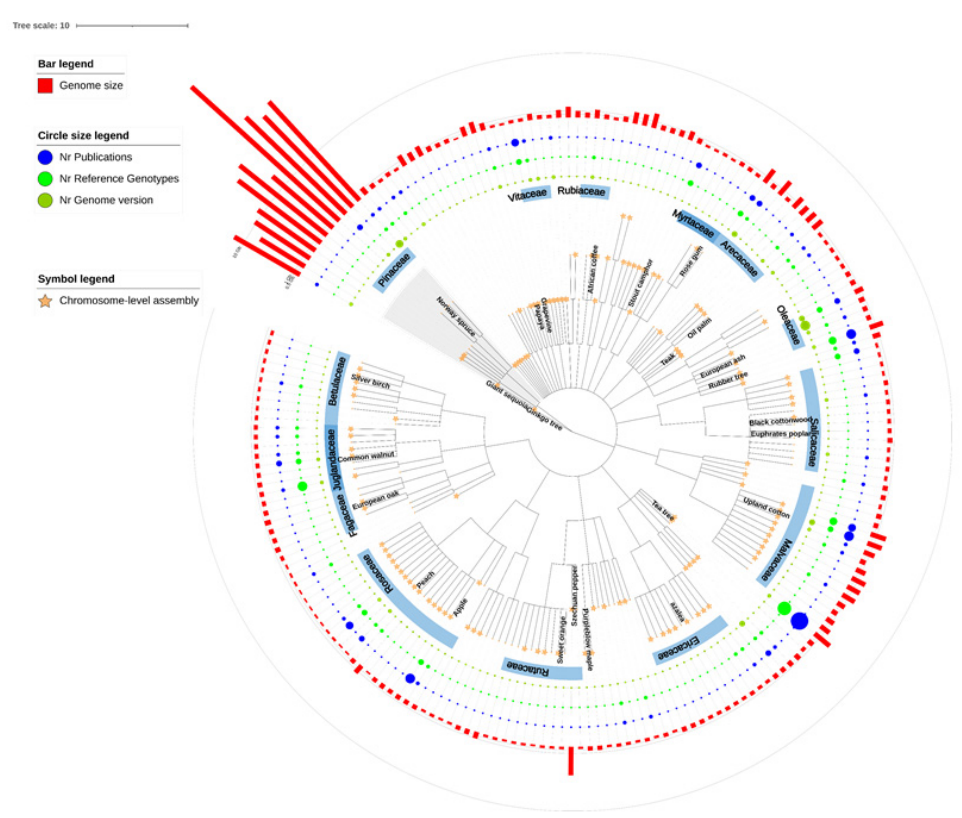
Figure 1. Published reference genomes of trees and woody plant species. Phylogenetic relationships of 201 species were extracted from NCBI Taxonomy and displayed by using iTOL tool [19]. The gymnosperm clade is labeled in the grey background and the important tree families are highlighted. Star symbols indicate 125 species with chromosome-level reference genomes. Numbers of genome versions, genotype-specific reference genomes, and genome publications are visualized as sizing circles. The estimated genome sizes of species are shown as red bars in the outermost circle. Detailed data is available in Table S1.